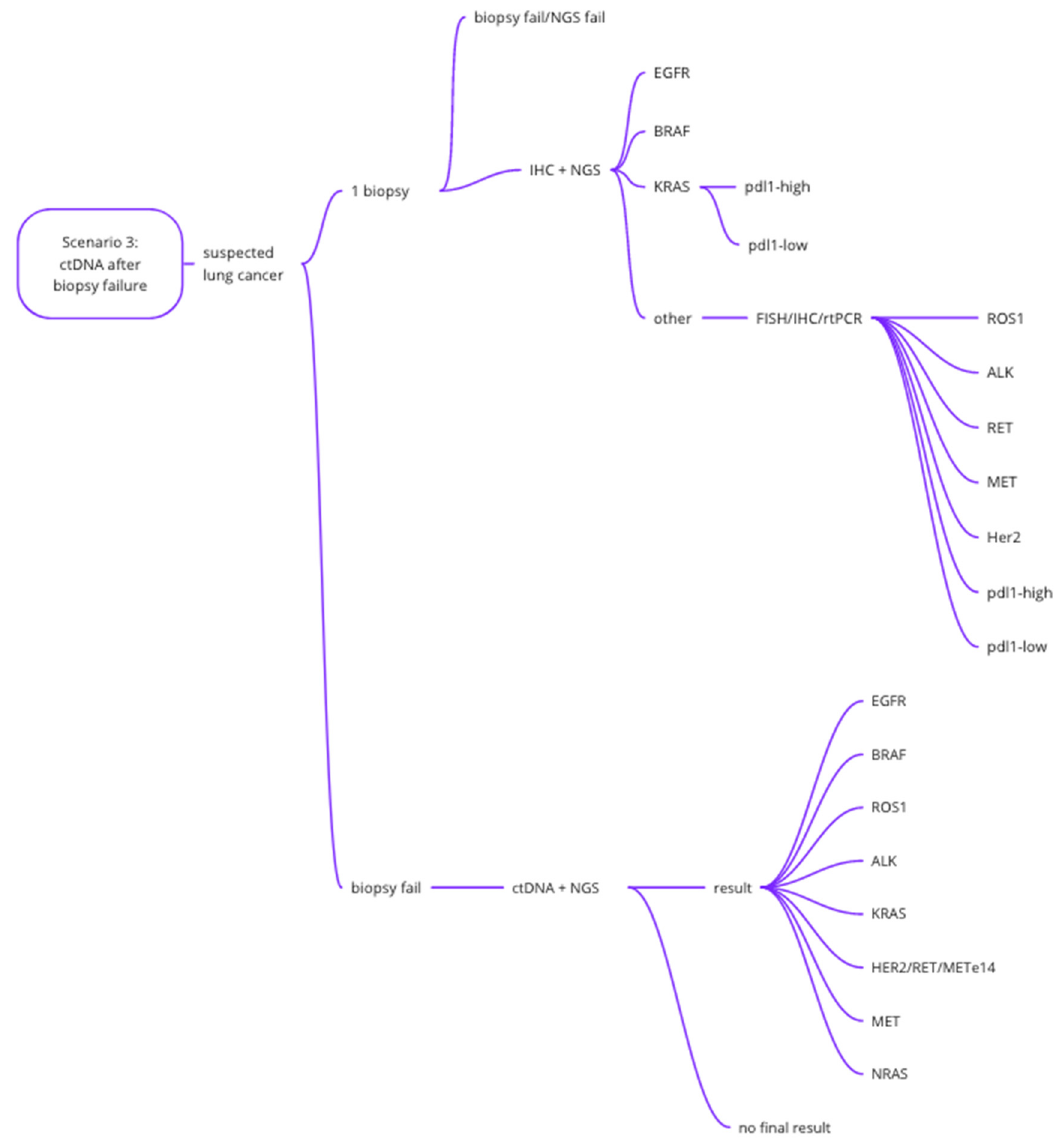
Figure 1. Schematic overview of the scenarios that are modeled in the discrete event simulation model.